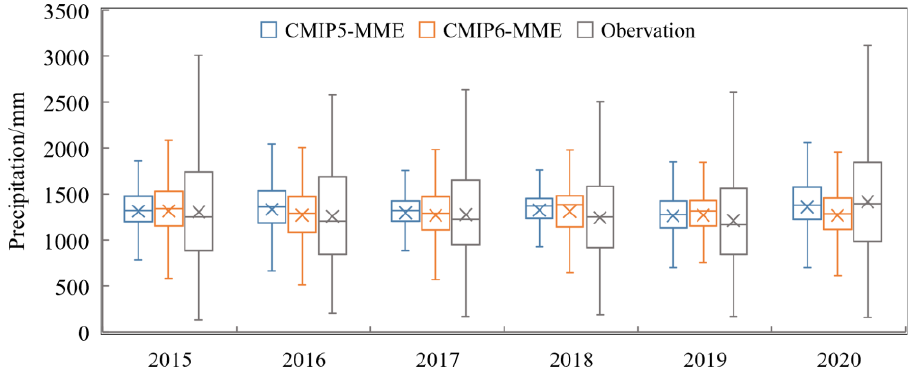
Figure 3. Box plot of average annual precipitation of CMIP5-MME, CMIP6-MME and observed data for each year from 2015 to 2020.